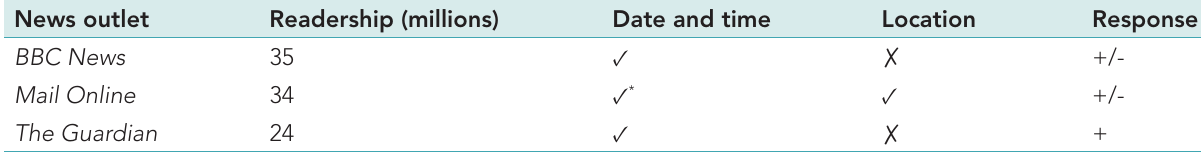
Table 2. Reach and comment functionality for three main UK news websites (Source: Authors, 2022)